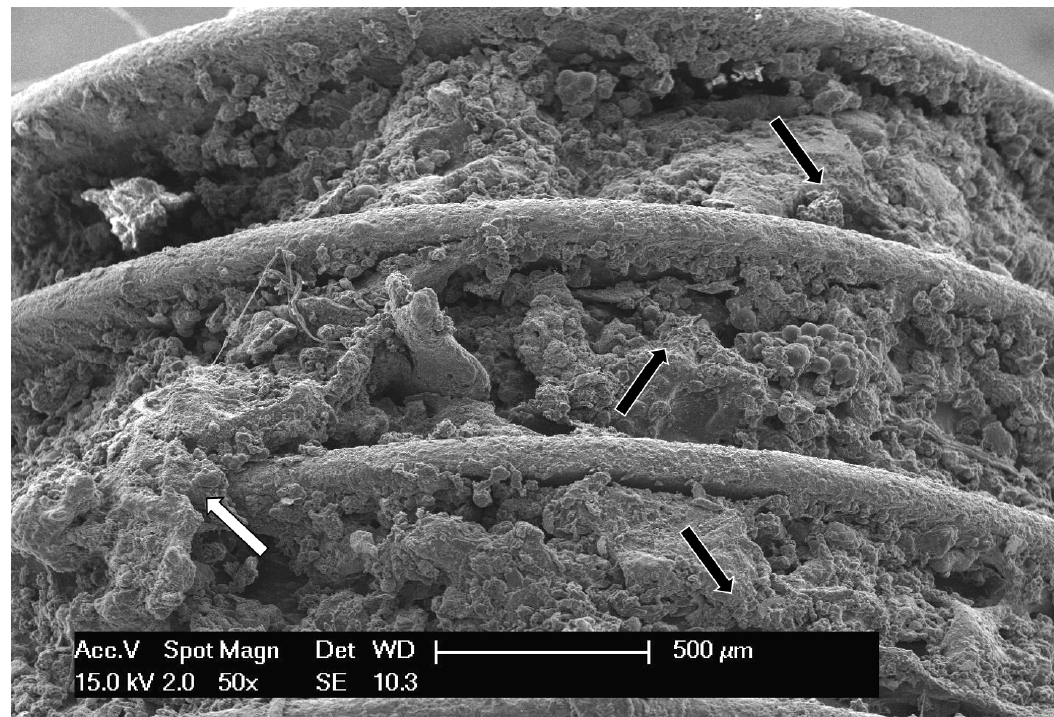
Figure 2. A low magnification (50 × ) electron micrograph of the implant. Three ridges of the screw are visible across the image, left to right. The voids among the threads are entirely occupied by growing bone tissue (black arrows): the new bone covering the entire fixture confirms the early osseointegration process. On the left, a bone patch crosses the metal ridges (white